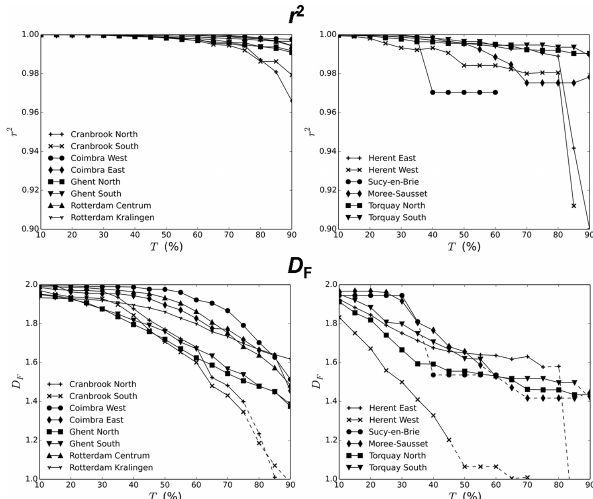
Figure 7. Fractal dimension analysis of the area covered by the sub- catchments with imperviousness greater than a threshold T for var- ious values of T : r 2 vs. T (top) and D F vs. T (bottom). On the bottom curves the dash portions correspond to thresholds for which r 2 < 0 . 99 meaning the estimates are less reliably robust (poorer qual- ity of the scaling). Fractal dimension are computed on the whole range of available scales (i.e. between 2m and 512–4096m accord- ing the study